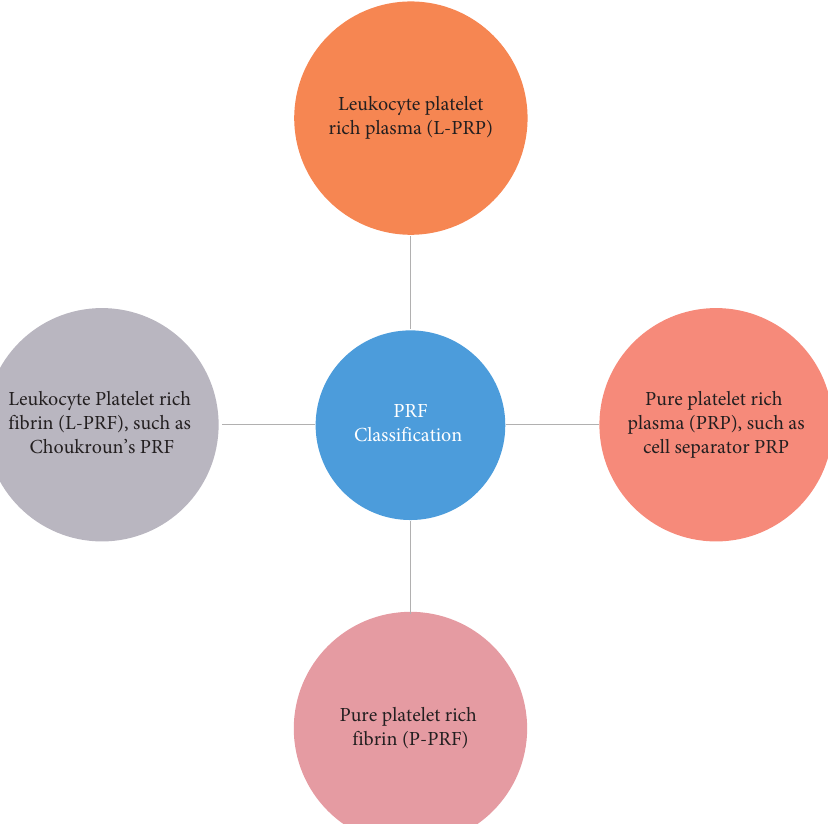
Figure 2: Classification based on